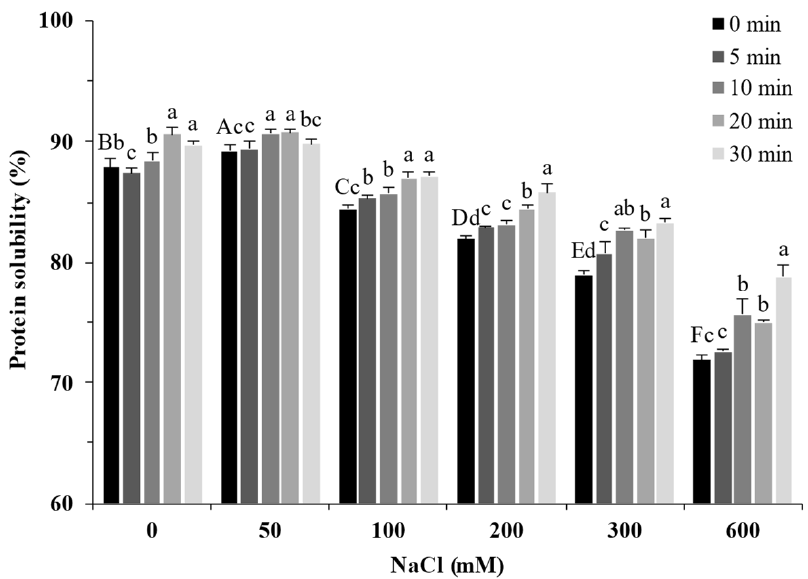
Figure 4. Solubility of soy protein isolate treated by ultrasound at different NaCl concentrations for different processing times. The upper letters indicate significant differences between the samples without ultrasound treatment in different salt concentrations. The lower letters indicate significant differences between the samples with different ultrasound times in the same salt concentration ( p < 0.05).